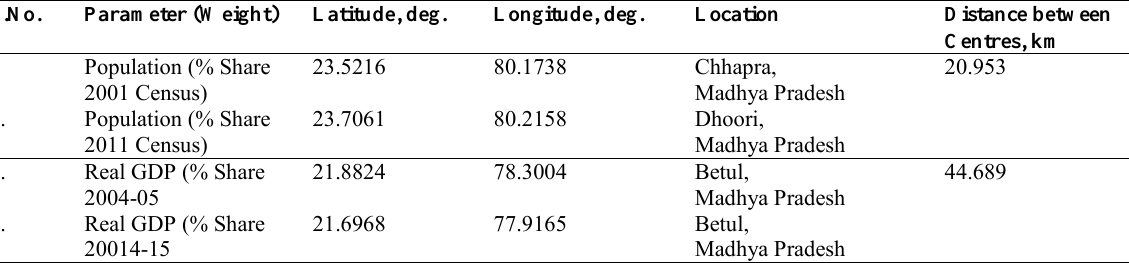
Table 5 Movements of Optimal Single-Facility Locations - States and UTs wise Analysis